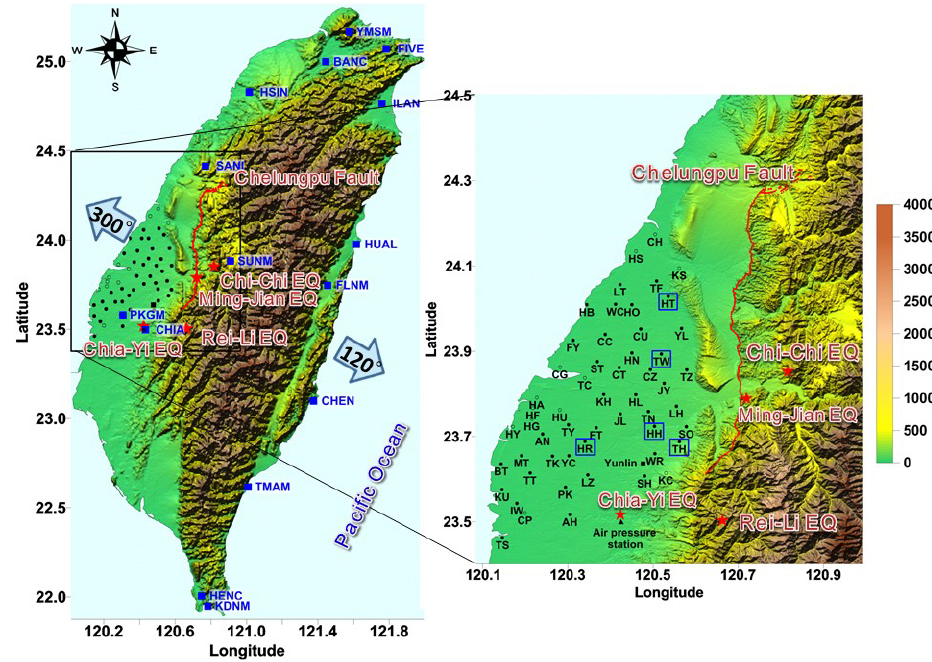
Figure 1. Locations of 4 earthquakes, 54 groundwater wells and 15 GPS stations in Taiwan.